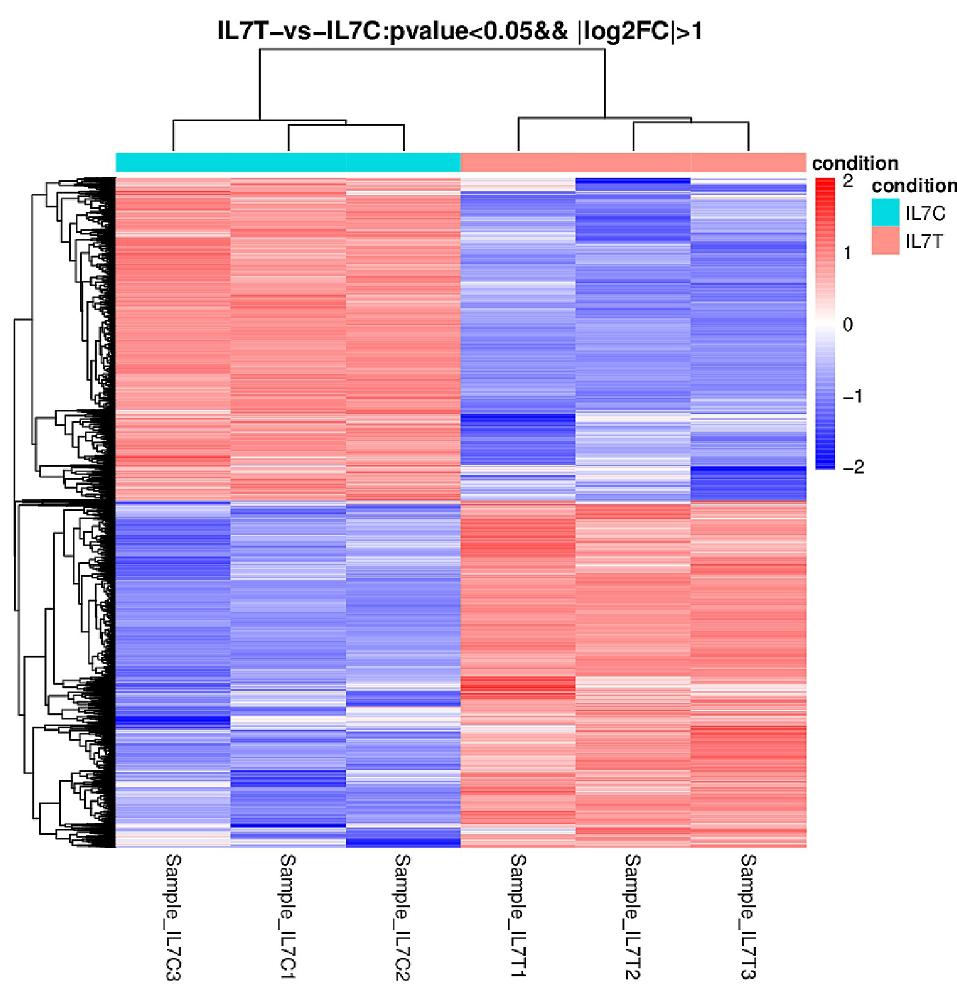
Fig 2. Heat map of IL7T vs IL7C ( P < 0.05, log2 |Fold Change| > 1). The deepening color in the heat map indicates an increase in the number of gene transcripts at that growth point.